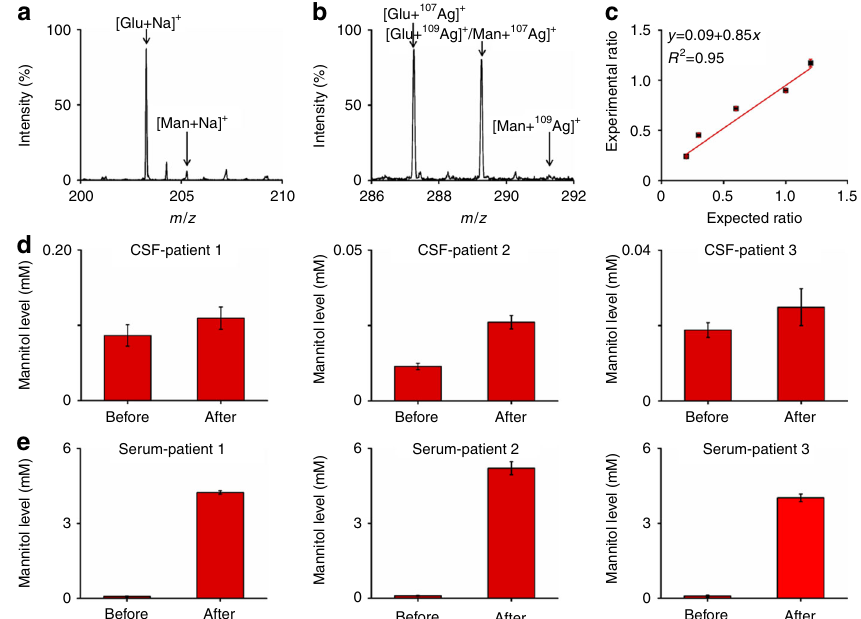
Fig. 4 Pharmacokinetic study based on mannitol detection in bio- fl uids. Mass spectra of 0.5 μ L of native serum showing a sodium-adducted and b silver- adducted characteristic molecular peaks of glucose and mannitol; c the calibration curve obtained by plotting experimental ratio of analyte/isotope (A/I) as a function of expected ratio of A/I for mannitol; mannitol levels as measured in d CSF and e serum from three patients before and 30 min after intravenous injection ( p < 0.05, Wilcoxon signed-rank test). Five independent experiments were performed for each sample to calculate the standard deviation (s.d.) as error bars . Data were shown as the mean ± s.d. ( n = endangers the human health by damaging the nerve systems 51, 52 .